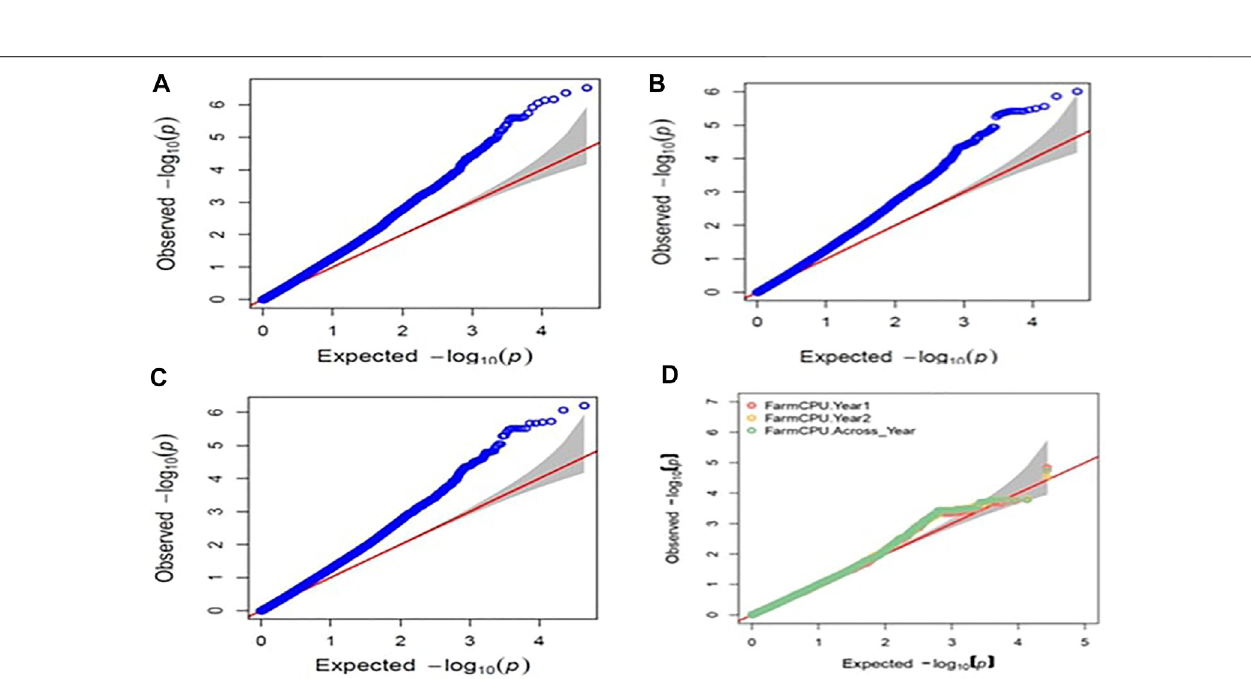
FIGURE 3 | Q-Q plots obtained for BPH resistance in GWAS for (A) 2016 GLM model (B) 2017 GLM model (C) pooled years using GLM model (D) pooled years using FarmCPU model.